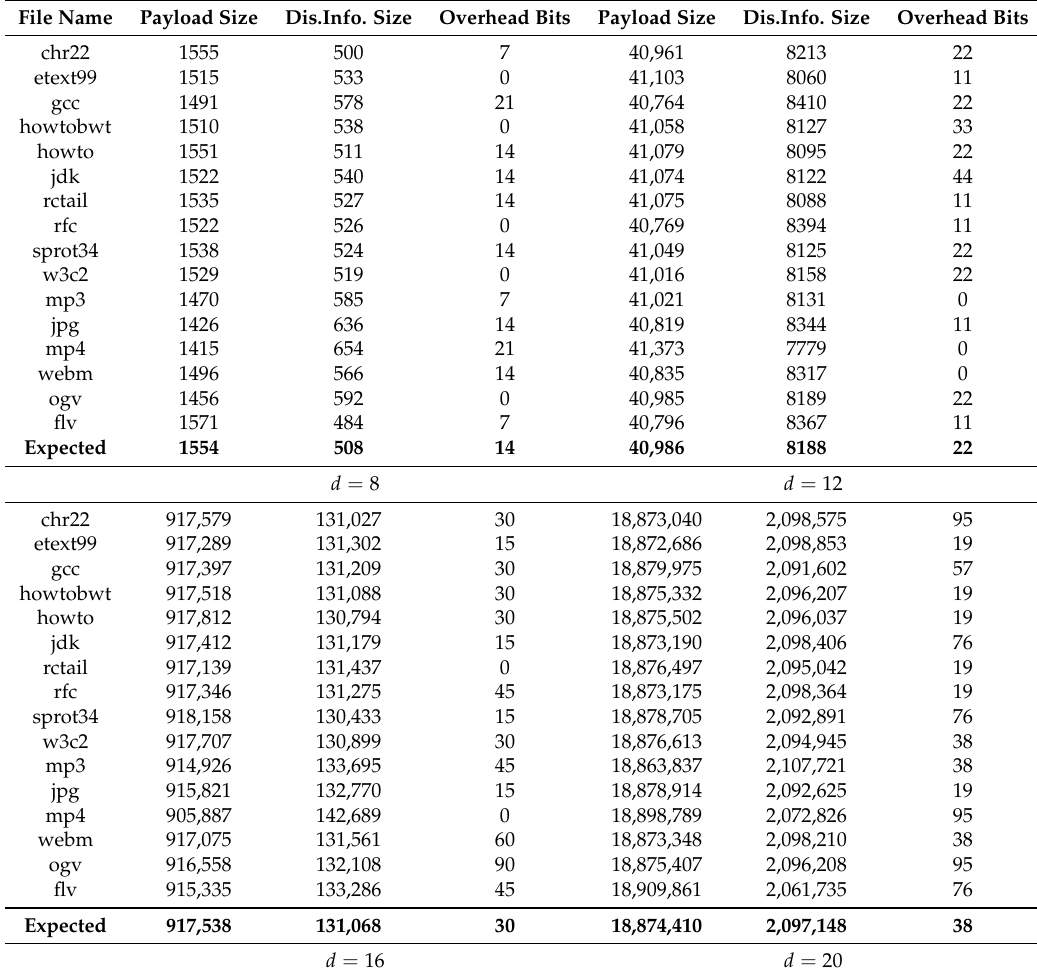
Table 2. Verification of the theoretical claims on selected files for d = { 8,12,16,20 }